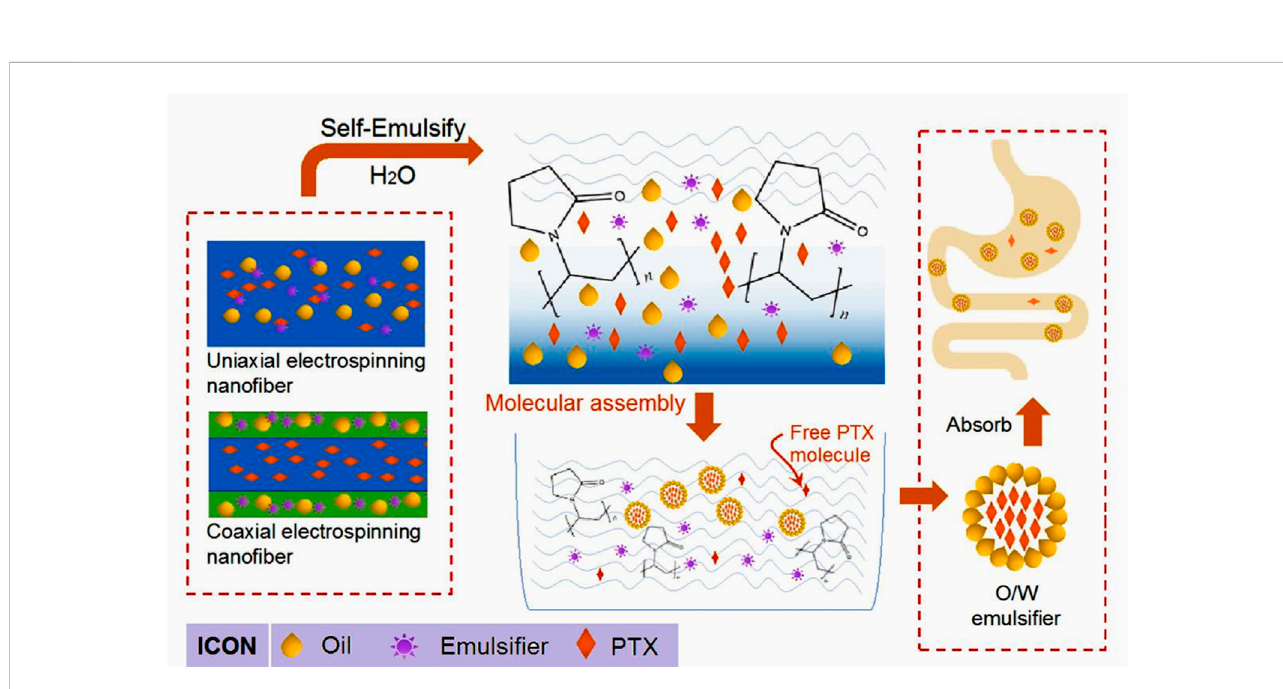
FIGURE 10 A molecular mechanism of electrospun nano fi ber-based